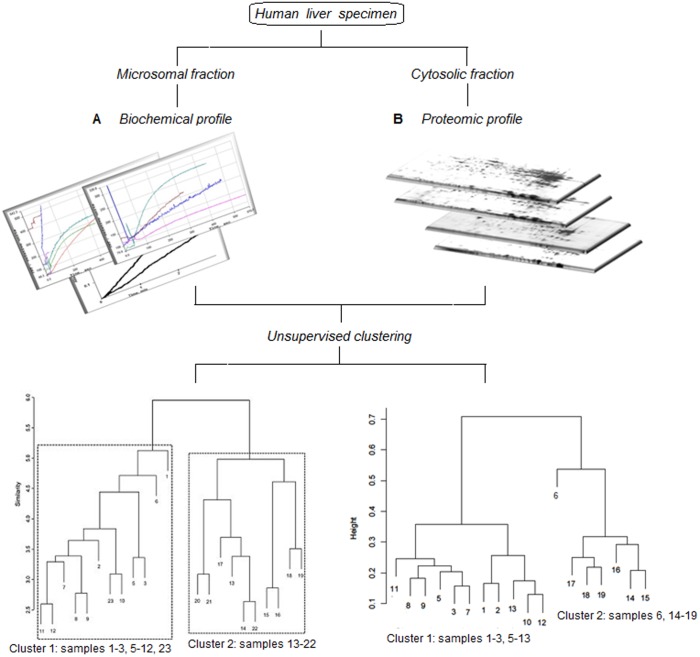
Schematic description of the comparative analysis of human liver biochemical (A) and proteomic (B) profiles.(A) The profile included 12 parameters, namely activity of NADPH-cytochrome P450 reductase, cytochrome P450 content and cytochrome P450-dependent monooxygenase activities with marker substrates (Petushkova et al., 2010). (B) The profile included 2DE images.